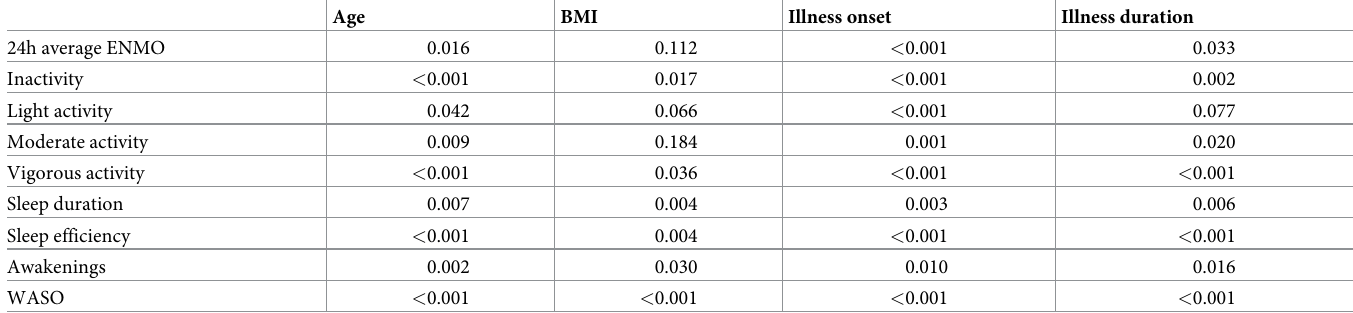
Table 5. Correlation coefficients (R) between demographic data and PA and sleep